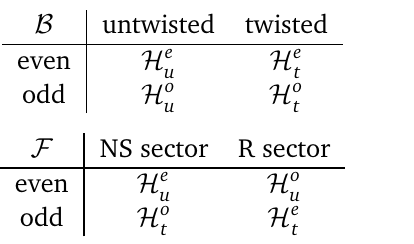
Table 3: A bosonic theory B on S 1 has either the untwisted or the twisted Hilbert space, depend- ing on whether a nontrivial (cid:90) holonomy along the circle is turned off or not. Each Hilbert space 2 can be further decomposed into the (cid:90) even and odd sectors. On the other hand, a fermionic 2 theory F on a circle has either the Neveu-Schwarz or the Ramond sector, depending on the peri- odic condition along S 1 . One can divide each sector into the ( − 1 ) F even and odd sectors where F denotes the fermion number